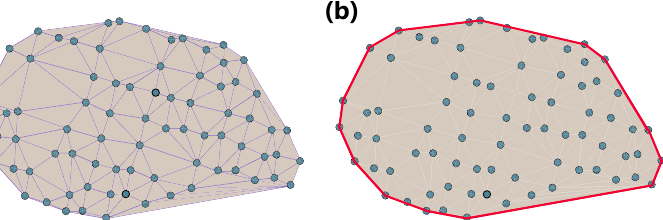
Figure 5. Triangulation generation and boundary extraction of dense point cloud based on Gra- ham algorithm: ( a ) represents triangular mesh generation; ( b ) represents boundary extraction.